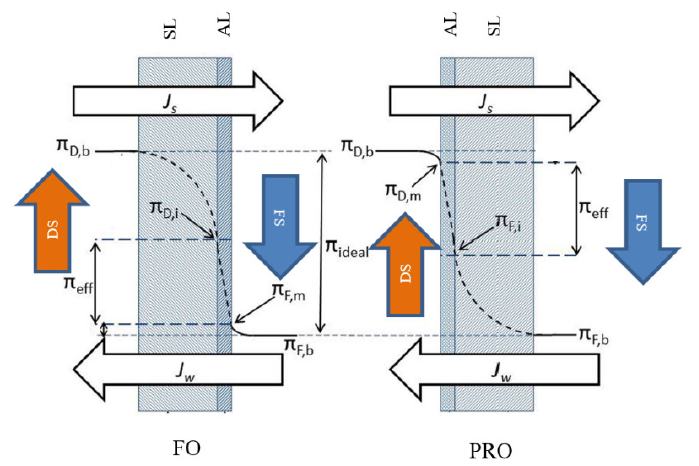
Figure 4. FO modes of operation [27] (Permission No. 5322071342556): FS, feed solution; DS, draw solution; AL, active layer; SL, support layer; J w , water flux; J s , solute flux; π D,b , bulk osmotic pressure of draw solution; π F,b , bulk osmotic pressure of feed solution; π D,i , osmotic pressure at the support layer adjacent to the active layer of draw solution side; π F,m , osmotic pressure at the active layer of feed solution side; π D,m , osmotic pressure close to the active layer of draw solution; π F,I , osmotic pressure at the support layer adjacent to the active layer of feed solution side; π eff , effective osmotic pressure.